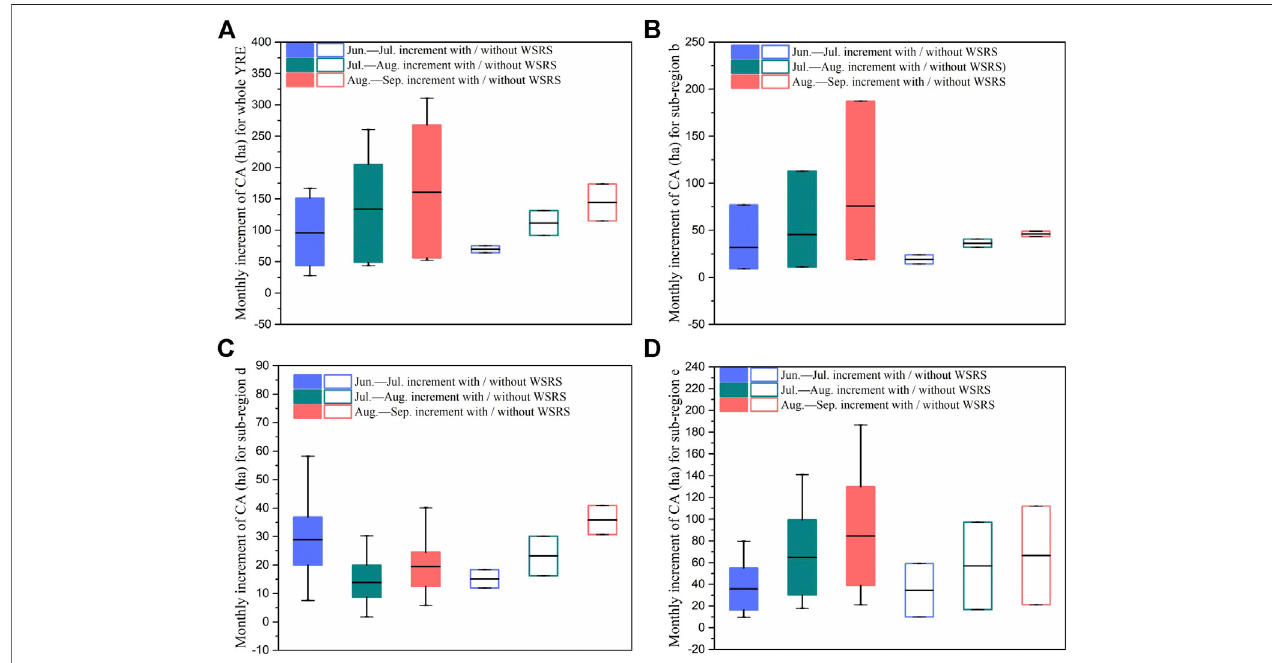
FIGURE 4 | Ranges and means of monthly increment of CA (class area) of S. alterni fl ora for (A) the whole YRE (B) sub-region b (C) sub-region d (D) sub-region e from June to September during 2011 to 2018.